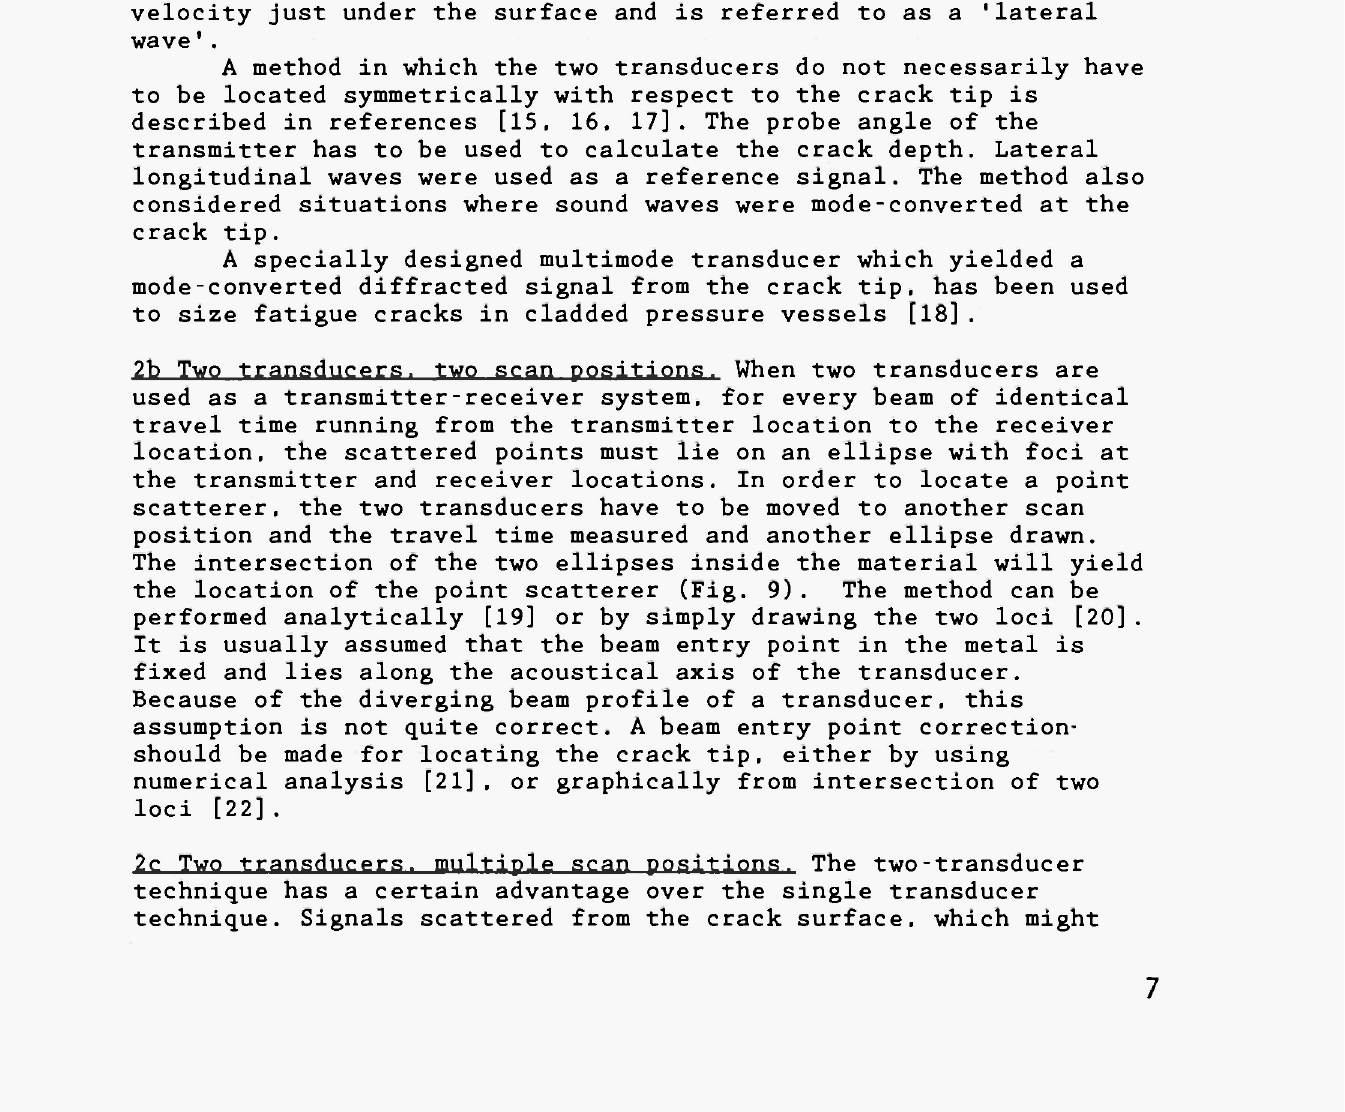
Fig. 8 Sizing crack depth with a symmetrical probe